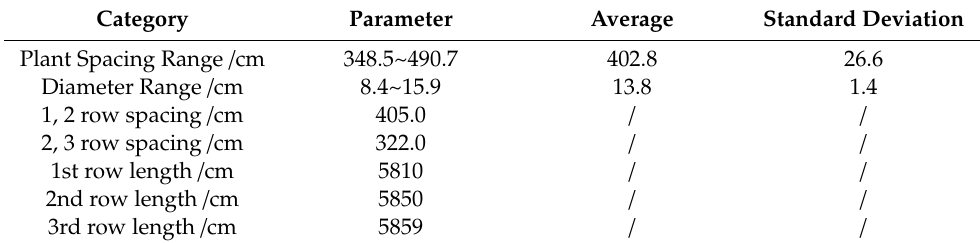
Figure 11. Actual parameter measurement in the test forest. ( a ) Position measurement. ( b ) Circumference measurement. Table 2. The parameters of the tested forest.